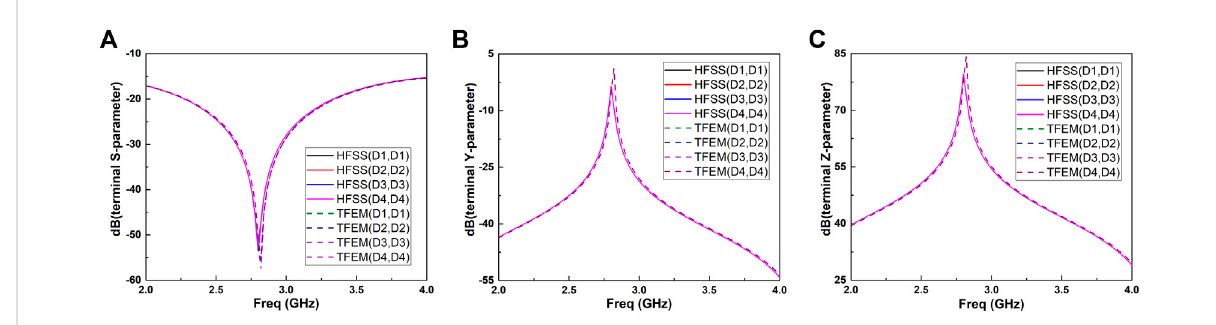
FIGURE 10 Comparisons of terminal (A) S-parameters, (B) Y-parameters and (C) Z-parameters of differential pairs between HFSS and the developed tool (TFEM).